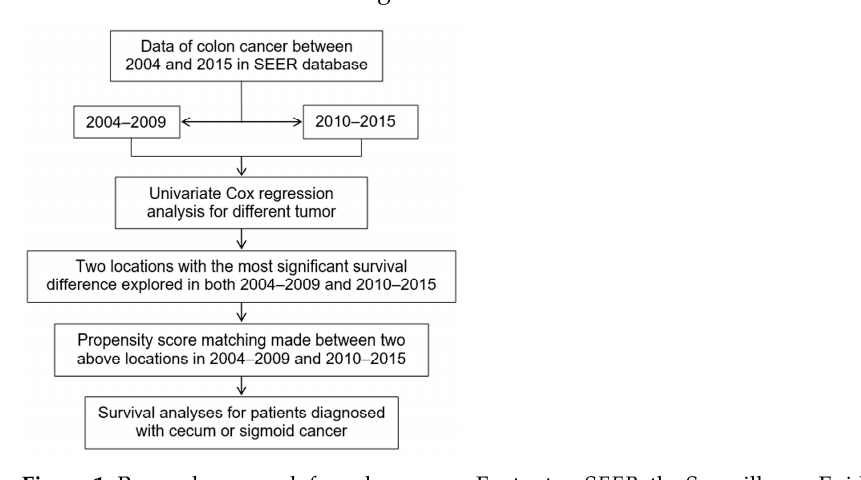
Figure 1. Research approach for colon cancer. Footnotes: S EER , the Surveillance, Epidemiology, and End Results.